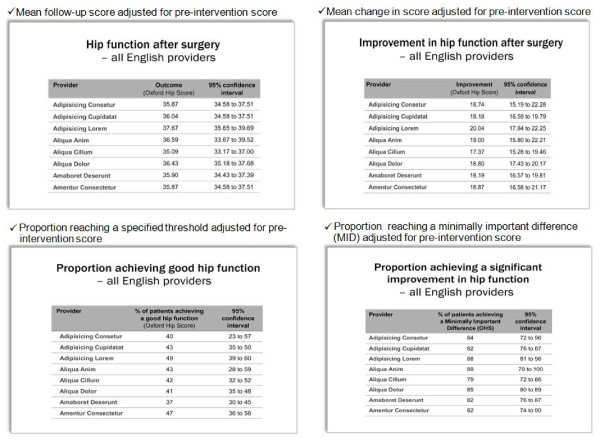
Metrics displays.